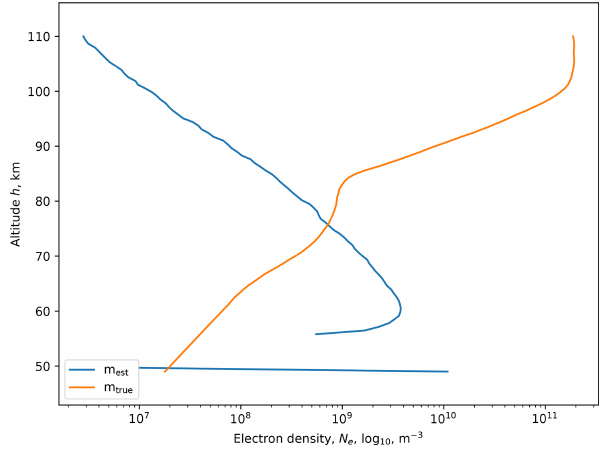
Figure 10. Fit of an electron density profile (SVD method). The discontinuity corresponds to the minimum altitude of the input col- lision frequency